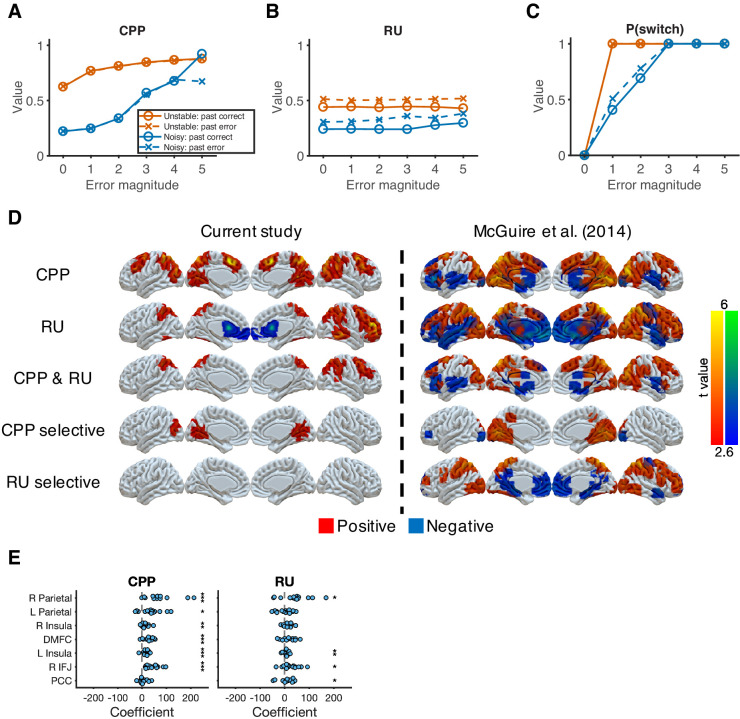
Reduced Bayesian model applied to behavioral and imaging data.(A) Model prediction for CPP. We calculated CPP from the fitted reduced Bayesian model, which incorporates subjective estimates of hazard rate and noise for each condition. The value of CPP increases as the current error magnitude increases in both conditions, but with a stronger dependence on the outcome of the previous trial in the noisy condition. (B) Model prediction for RU. We calculated RU from the fitted reduced Bayesian model, which incorporates subjective estimates of hazard rate and noise for each condition. The value of RU is minimally affected by the current error magnitude. Instead, a past error tends to increase RU. (C) Model prediction for probability of switching choices. Increasing CPP causes the probability of switching to increase more steeply as the current error magnitude increases in the unstable condition versus in the noisy condition. For small errors (error magnitude of 1 and 2) in the noisy condition, the probability of switching is further influenced by RU, which is affected by past errors. (D) Neural representation of CPP and RU. CPP selective effect represents the conjunction of CPP > 0 and CPP > RU. RU selective effect represents the conjunction of RU > 0 and RU > CPP. The results were thresholded based on uncorrected voxel p<0.01 (t = 2.6). (E) ROI analysis for CPP and RU. These ROIs were selected based on the common regions of CPP, RU, and reward effects in McGuire et al., 2014. Significance was tested by a sign test. *p<0.05, **p<0.01, ***p<0.001.